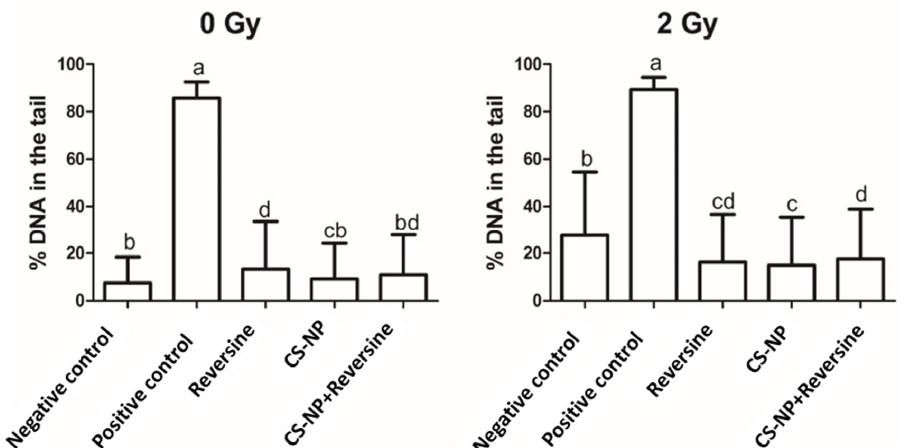
Figure 4. Percentage of DNA damage in non-irradiated (0 Gy) and X-ray irradiated (2 Gy) MCF-7 cells as measured by the alkaline comet assay. H 2 O 2 at 100 μM was used as the positive control. The bars represent the mean value and the lines represent the standard deviation. Bars with same letter (a, b, c, d) are not significantly different (Dunns > 0.05). The average values for non-irradiated (0 Gy) samples: negative control, 7.4 ± 0.30; positive control, 85.7 ± 6.7 reversine, 13.2 ± 0.59; CS-NP, 9.2 ± 0.43; CS-NP + reversine, 11.0 ± 0.48. Average values for X-ray irradiated (2 Gy) samples: negative control, 27.6 ± 0.77; positive control, 89.3 ± 0.14; reversine, 16.2 ± 0.59; CS-NP, 14.9 ± 0.59; CS-NP + reversine, 17.6 ± 0.61.